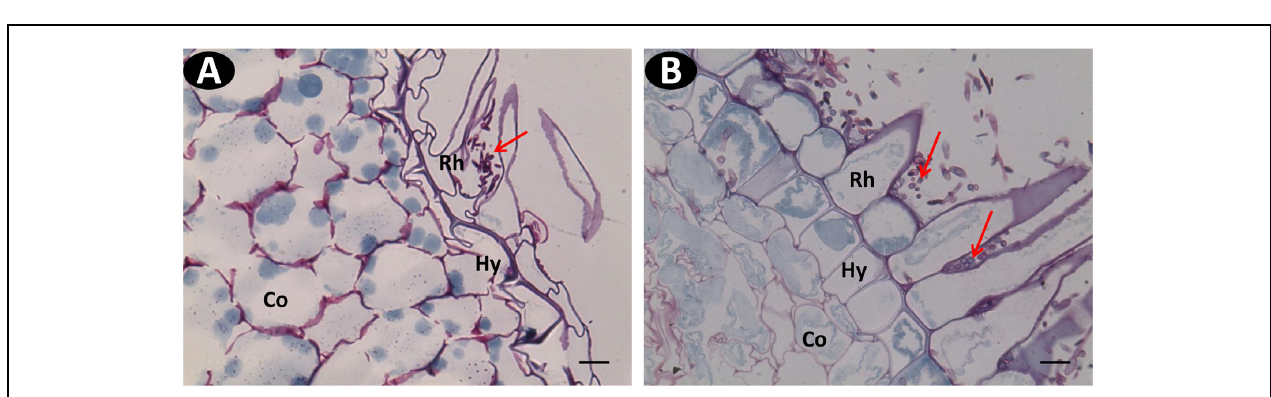
FIGURE 6 | Wide field microscopy images of transverse sections of Schiff Naphthol Blue-black double-stained vanilla root tissues infected with pathogenic Fo072 at 3 dpi. (A) Transverse root section of the resistant accession pom0018 showing lesser colonization of hyphae (red arrows) in the hairy root region, compared to (B) susceptible accessions pla0001 showing abundant fungal colonization. Rh: Rhizodermis, Hy: hypodermis, Co: cortex. Scale bar = 20 μ